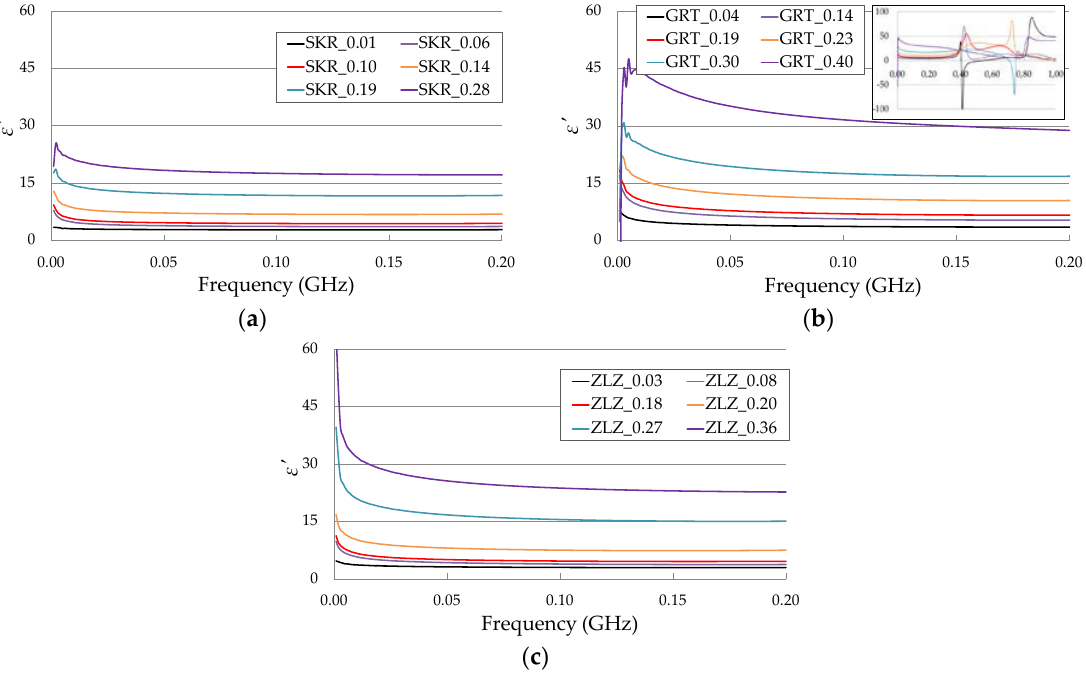
Figure 6. The ε (cid:48) values of SKR ( a ), GRT ( b ), and ZLZ ( c ) soil samples with different water contents over the frequency range from 1 MHz to 200 MHz. The name of each sample consists of the type of soil and the θ value. Three VNA measurements from various soil samples were performed for each moisture content. The curves present the average values with the maximum value of the standard error ± 3%.